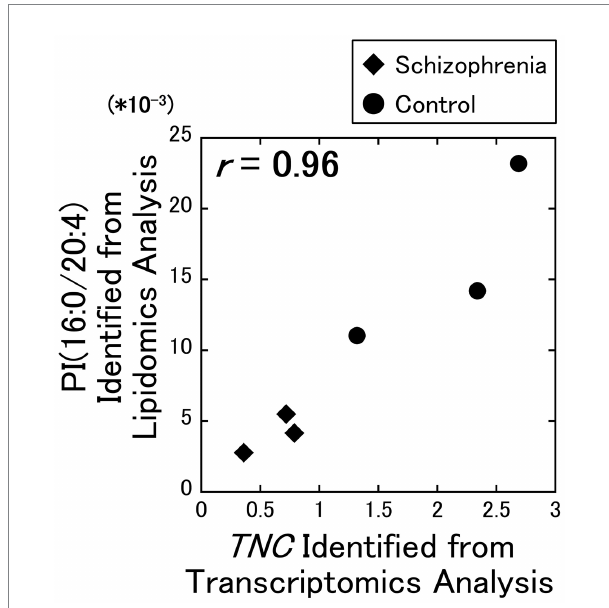
FIGURE 1 Relationship between the lipidomics and the transcriptomics factors. The signal intensity of the PI (16:0/20:4) were plotted against the RPKM of the TNC gene. All data including other lipids and DEGs are available on Supplementary Figure 1. Diamonds: samples from schizophrenia patients. Circles: samples from control